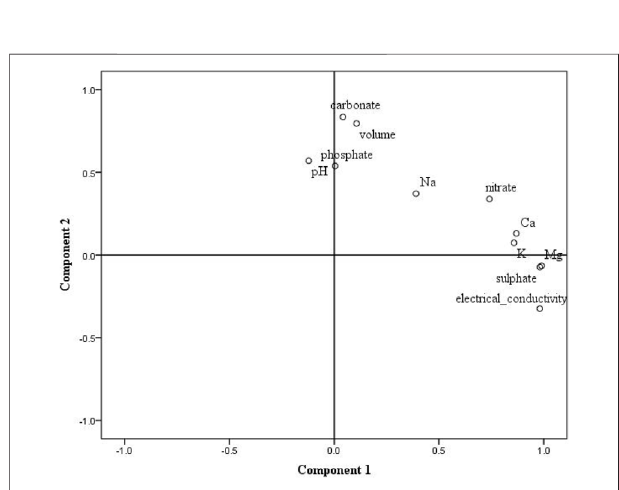
FIGURE 8 | Principal component analyses for leachate properties from sediments from Datang, Jiangtian, and Xiahui badlands, China and Araguás badlands,